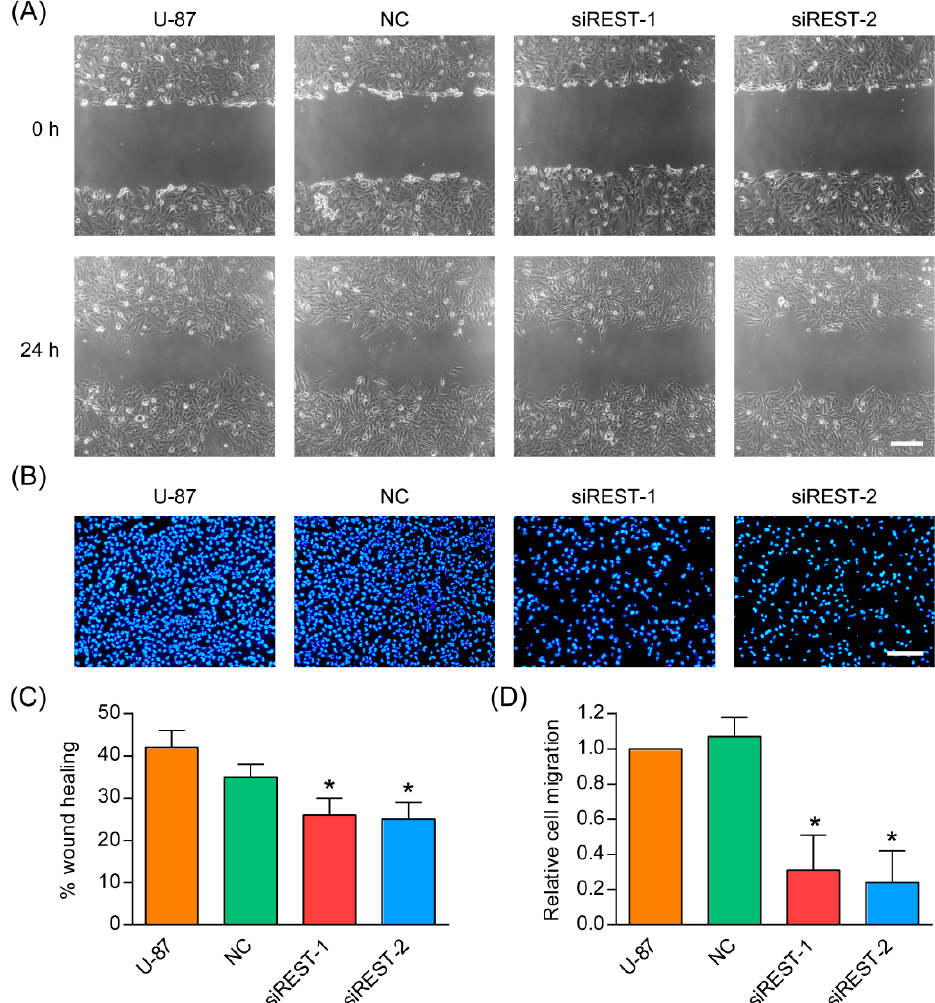
Figure 6. REST silencing reduced migration of U-87 cells. ( A ) In vitro scratch assay carried out with U-87 cells over 2 h; ( B ) Transwell migration assay was conducted with U-87 cells over 12 h; ( C ) The quantification of wound healing assay; ( D ) The quantification of transwell assay. * p < 0.05 compared with NC group. Scale bars in A and B indicate 200 nm.